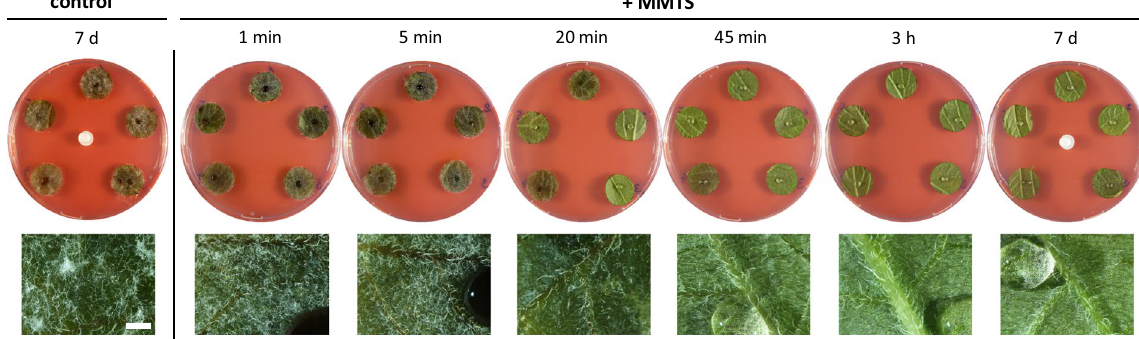
Figure 2. The inhibitory effect of MMTS on late blight over time. Leaf discs from Bintje adult plants (n = 5) were inoculated with P. infestans and simultaneously exposed to 1 mg MMTS (or solvent used as control). At different time points (1 min to 3 h), the septum carrying the volatile was removed to stop the volatile treatment. Pictures are shown after six days of incubation and are representative of three technical replicates. Binocular pictures taken from the first disc of each box are shown below. Scale bar = 1 mm.